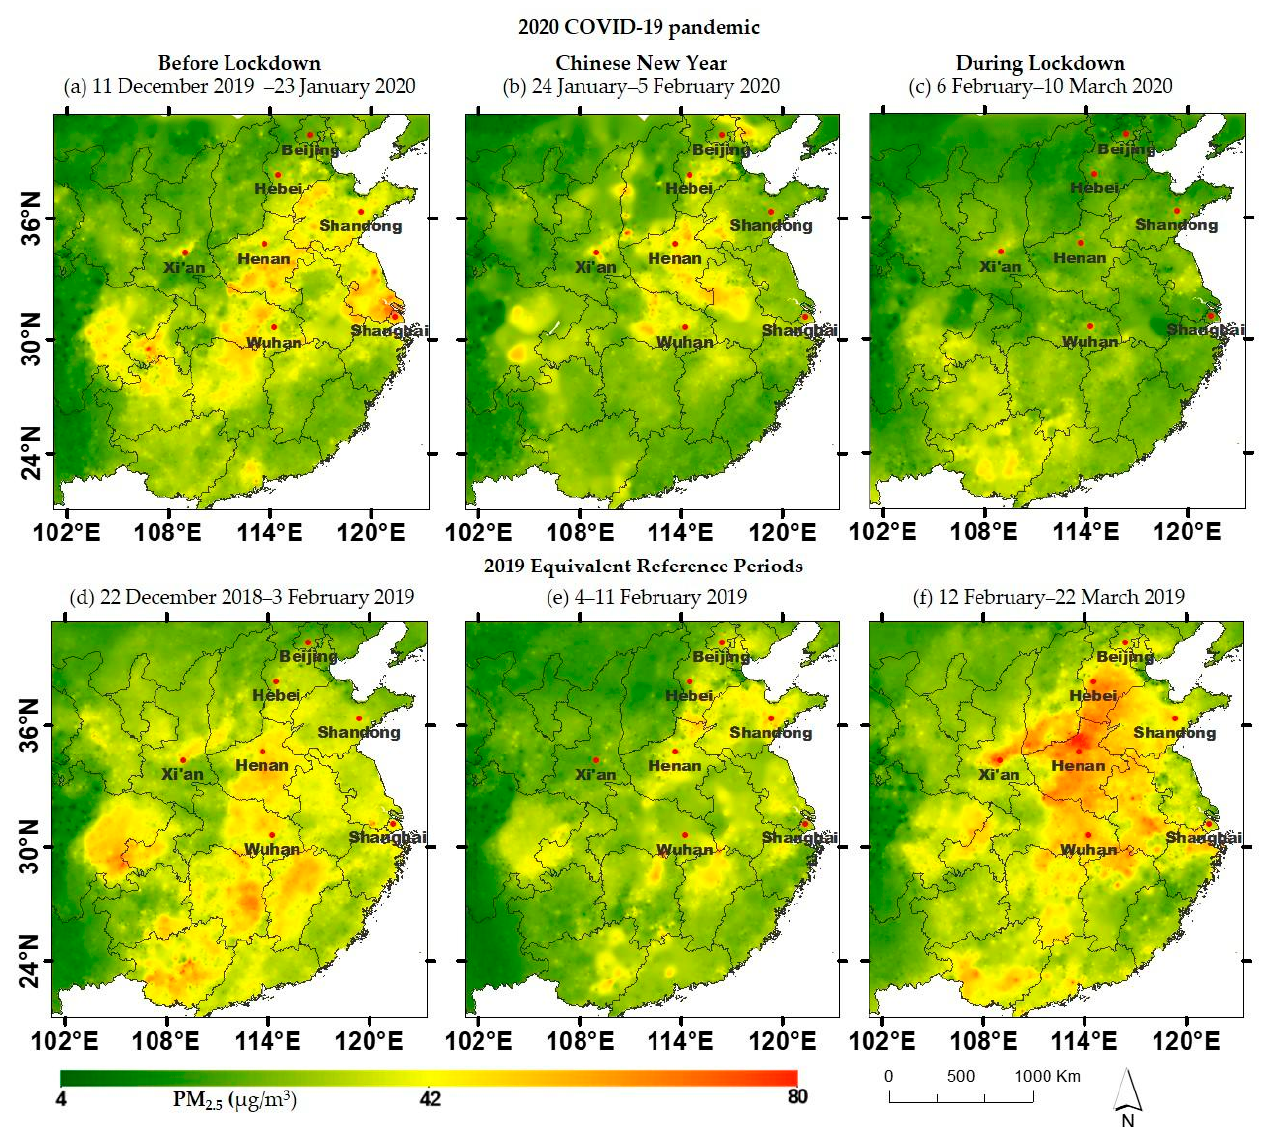
Figure 7. Above: Daily mean satellite-derived PM 2.5 over China in early 2020 for three sequential periods ( a ) before lockdown (BLK), ( b ) Chinese New Year (CNY), and ( c ) during lockdown (DLK). Below: Corresponding reference periods of equal duration ( d , e , f , respectively) with respect to the start of the Chinese New Year in 2019.